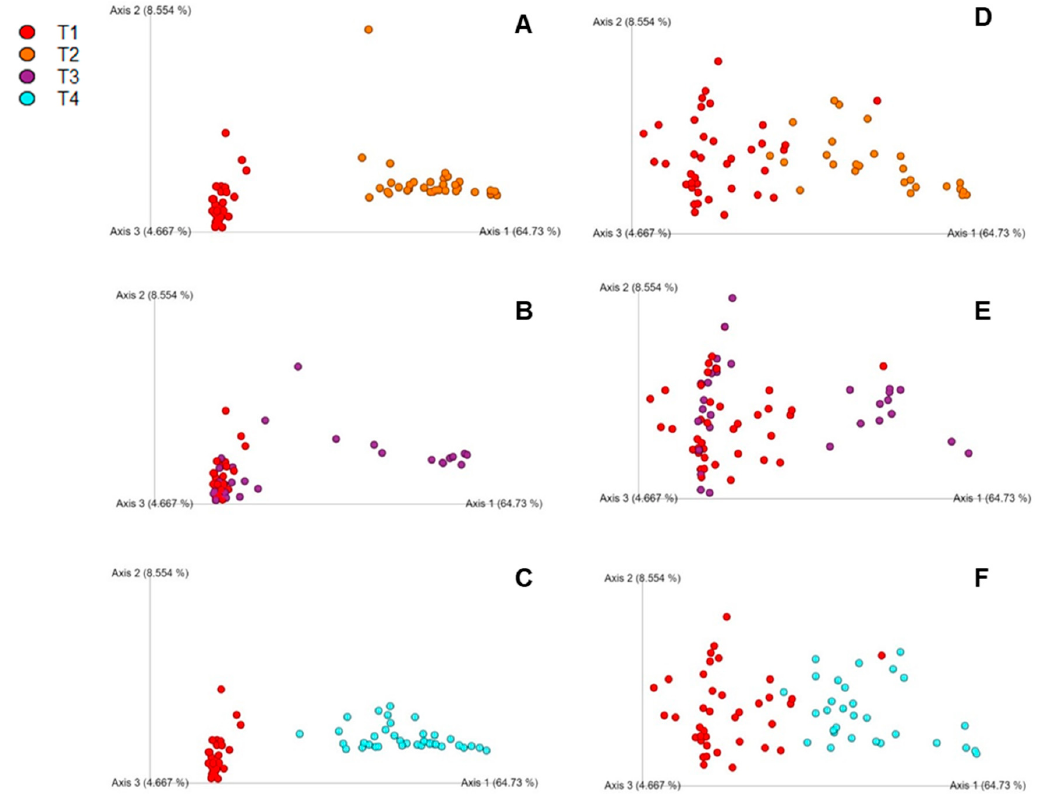
Figure 4. ( A–C ) Principle coordinate analysis (PCoA) charts using Unifrac for day 2 comparison of treatments: ( A ) T1 vs. T2, ( B ) T1 vs. T3, ( C ) T1 vs. T4; ( D–F ) PCoA charts using Unifrac for day 4 comparison of treatments: ( D ) T1 vs. T2, ( E ) T1 vs. T3, ( F ) T1 vs. T4. The legend is located at the top left of the figure. Table 3. ANOSIM analysis of weighted Unifrac on different day comparisons within each of the treatment groups.